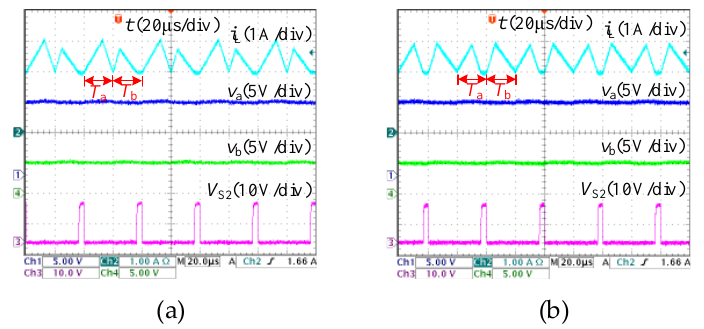
Figure 13. Steady-state experimental waveforms of PCCM SIDO buck converter: ( a ) the maximum load current of output A; ( b ) the maximum load current of output B.